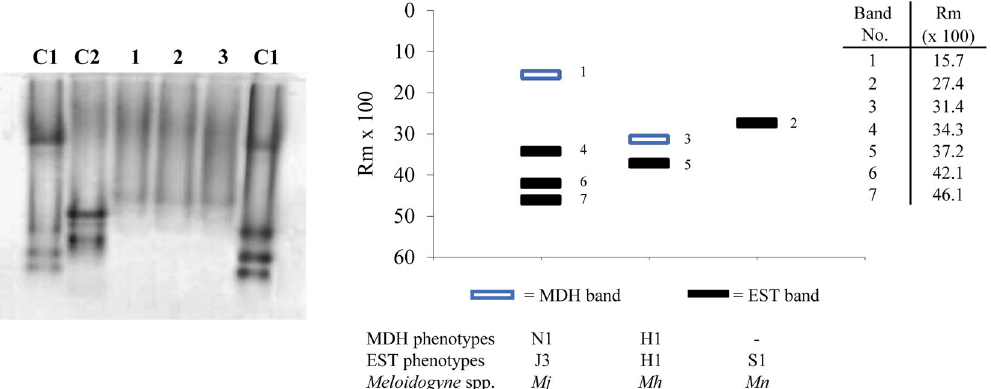
Figure 3. Esterase (EST) and malate dehydrogenase (MDH) phenotypes from egg-laying females of Meloidogyne nataliei , and M . javanica and M . hapla used as controls. C1- extract from one female of M . javanica (J3; N1) per well; C2 - extract of five females of M . hapla (H1; H1) per well; Lanes 1, 2, and 3 - extract from five females of M . nataliei (S1) per